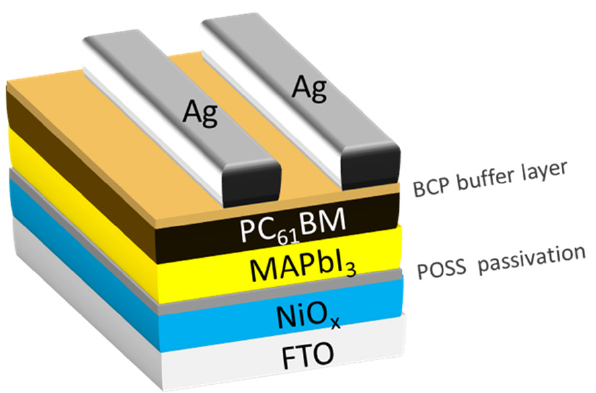
Figure 1. The schematic representation of structure of designed perovskite solar cells (PSCs).